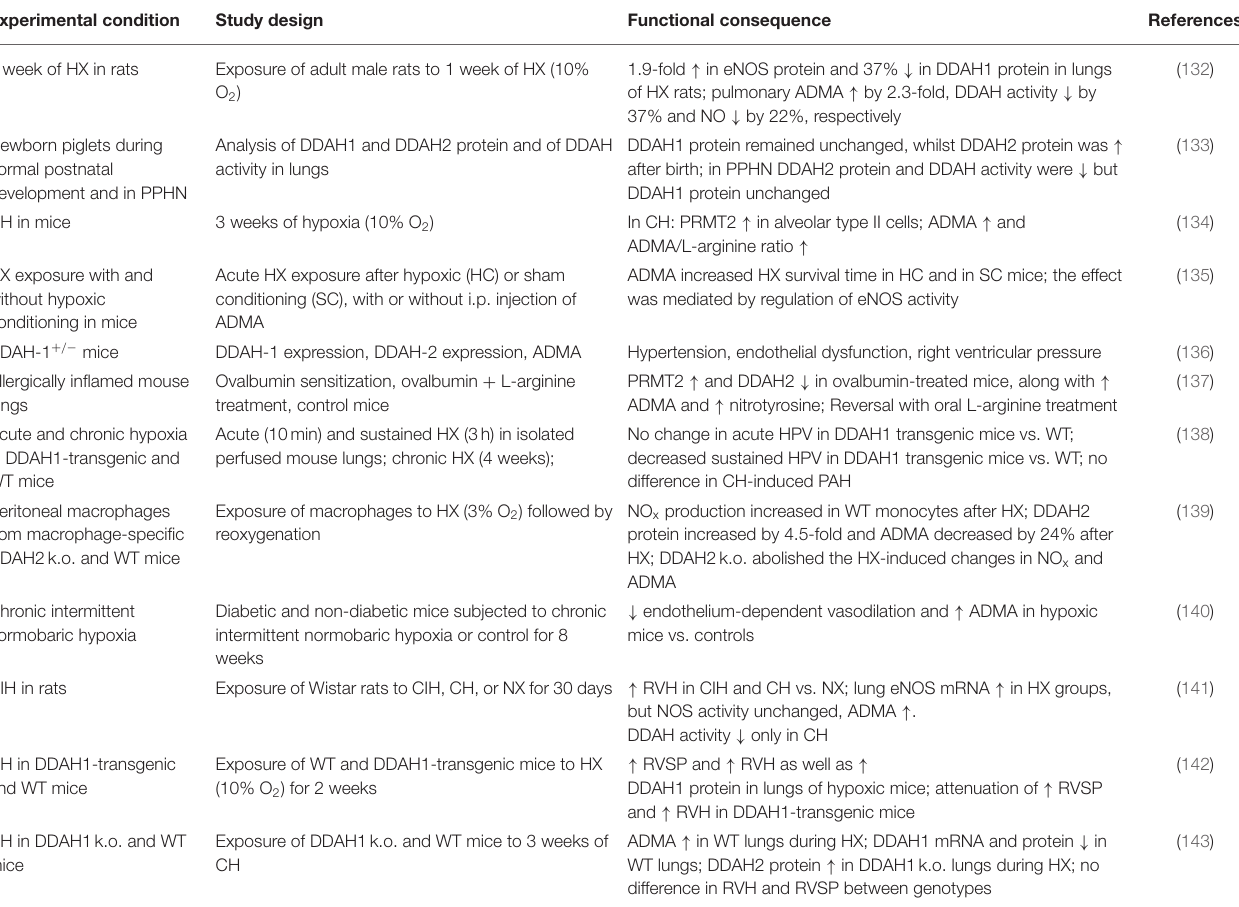
TABLE 2 | Experimental models linking derangement of the ADMA/DDAH pathway with pulmonary hypoxia and pulmonary vascular